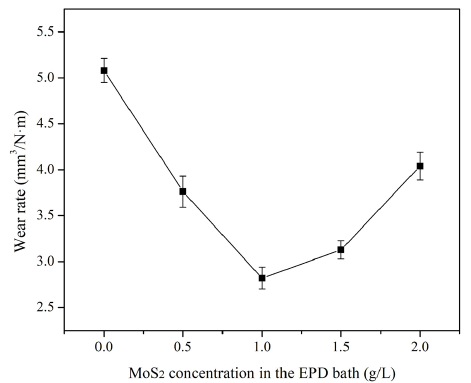
particles; (b) and (c) adhesive wear 2 2